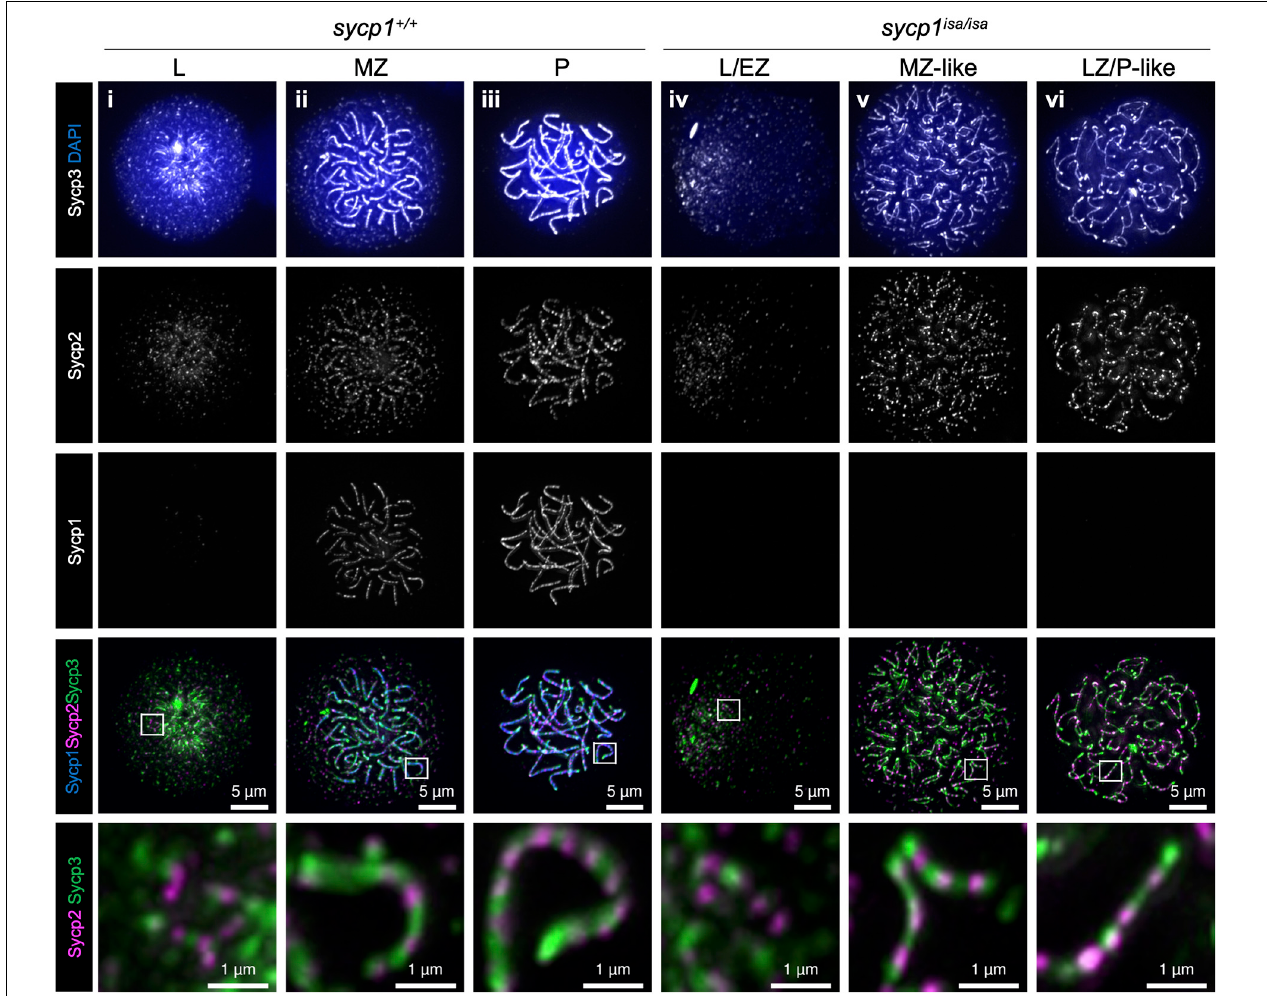
FIGURE 3 | Formation of chromosomal axes in sycp1 mutant spermatocytes. Immunostaining of Sycp3, Sycp2 and Sycp1 components in wild-type ( sycp1 + / + , i to iii) and sycp1 isa / isa (iv to vii) spermatocyte chromosome spreads. Wild-type nuclei at leptotene (L, i), mid-zygotene (MZ, ii) and pachytene (P, iii) were staged according to the staining patterns of Sycp3, Sycp2 and Sycp1 (Blokhina et al., 2019). sycp1 isa / isa nuclei at leptotene (L, iv), mid-zygotene-like (MZ-like, v) and late zygotene/pachytene-like (LZ/P-like, vi) stages were staged by axis staining patterns. Regions indicated in white rectangles are shown at the bottom at a higher